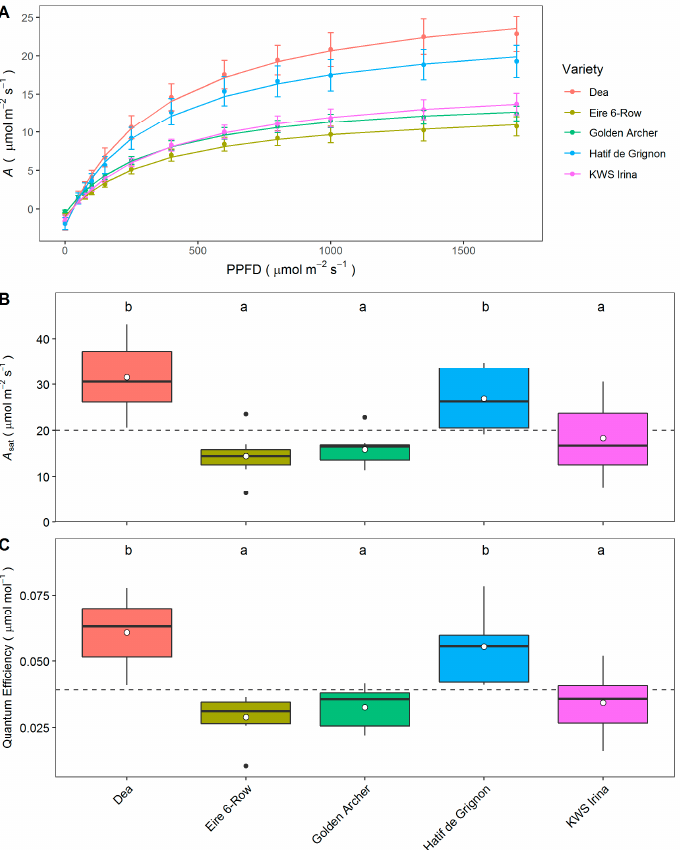
Figure 5. The assimilation response of 5 barley cultivars (the landraces Dea, Eire 6-Row, Golden Archer and Hatif de Grignon and the elite line KWS Irina) to changing light intensity (A-Q curves). Michaelis-Menten parameters were derived from A-Q curves. ( A ) Assimilation response to changing PPFD. Points and error bars reflect actual data, line derived from model. ( B ) Maximal value of assimilation based on model outputs at 1500 μ mol m − 2 s − 1 PPFD. ( C ) Initial slope (quantum efficiency) of response to changing PPFD based on model outputs. Data shown are means +/ − se in ( A ) and box-and-whisker plots in ( B ), ( C ), where white points are mean values. N = 5–6. Identical letters indicate no significant differences between means based on Tukey’s test of model outputs at p = 0.05.